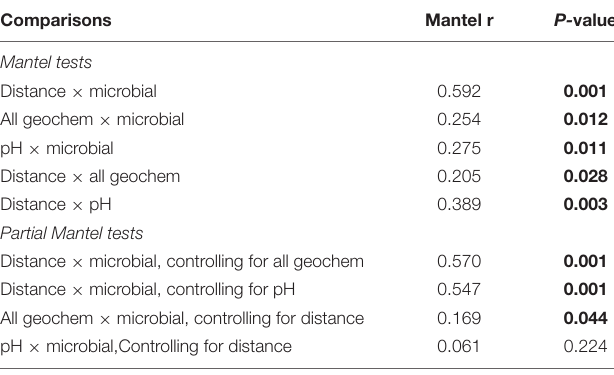
TABLE 1 | Correlations among microbial community composition (“microbial”), geographical distance (“distance”), and geochemical variables (“all geochem”: All geochemical variables; or “pH”: pH only) as determined by Mantel and partial Mantel tests on dissimilarity